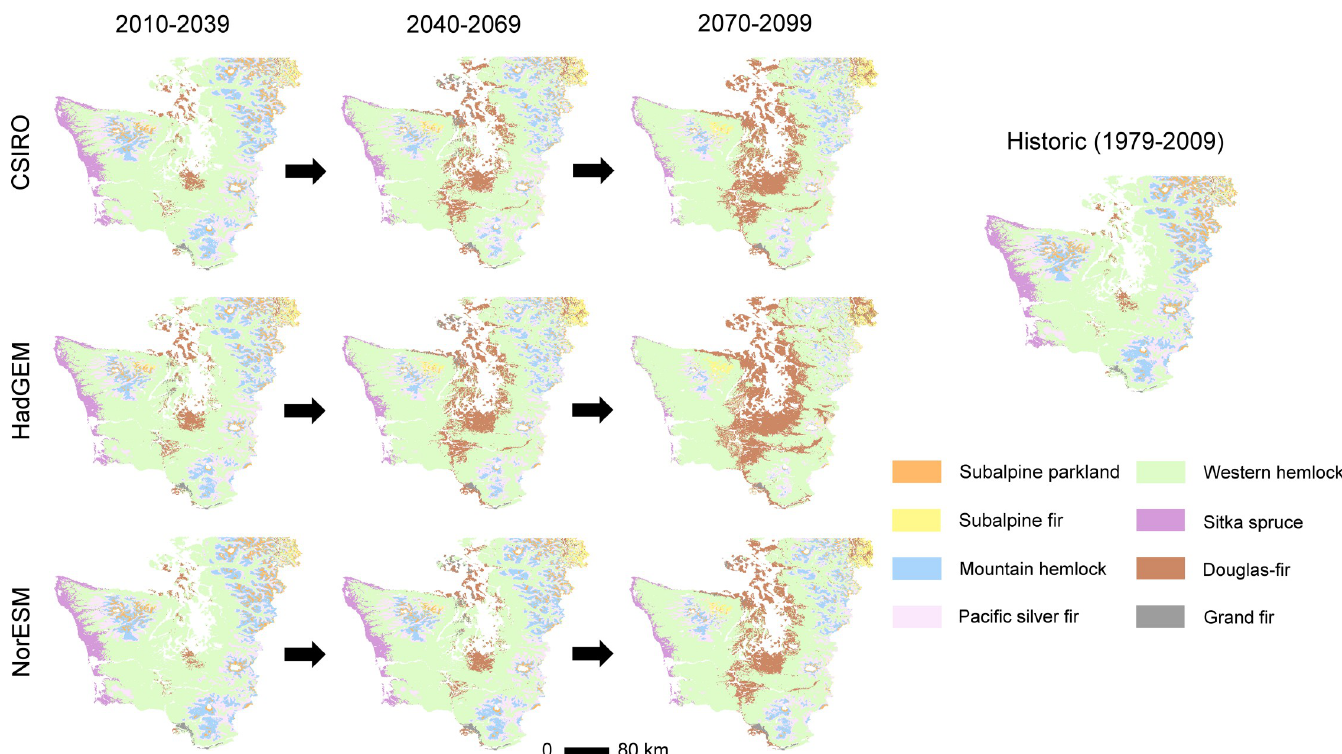
Fig 5. MC2 forest zone projections across three GCMs (30-year modal values). Maps represent vegetation potential based on biophysical properties and climate.